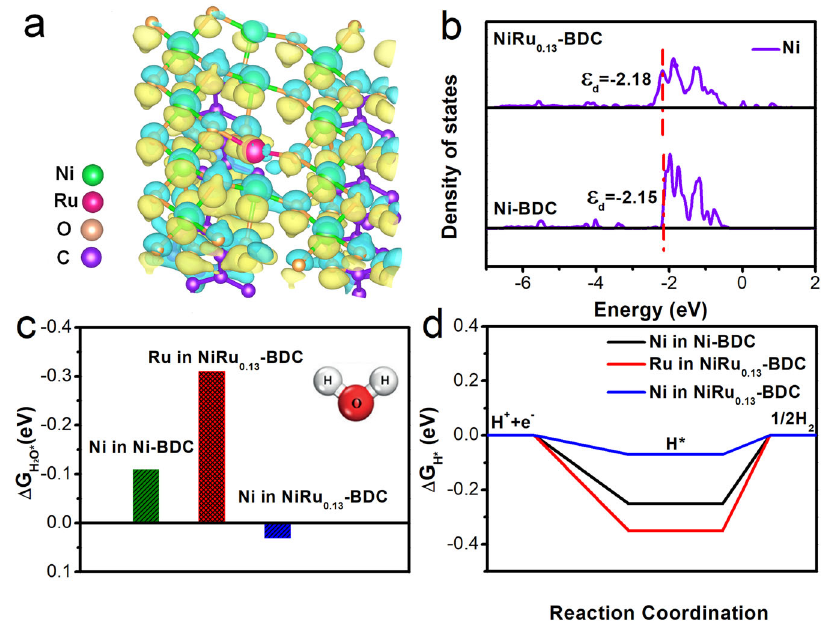
Fig. 5 DFT calculations. a The charge density difference between Ni-BDC and NiRu 0.13 -BDC. The yellow and blue color represent charge accumulation and depletion, respectively. b Calculated DOS of Ni in Ni-BDC and NiRu 0.13 -BDC. c The calculated adsorption free energy of water on Ni-BDC and NiRu 0.13 -BDC. d Calculated free energy diagram of the